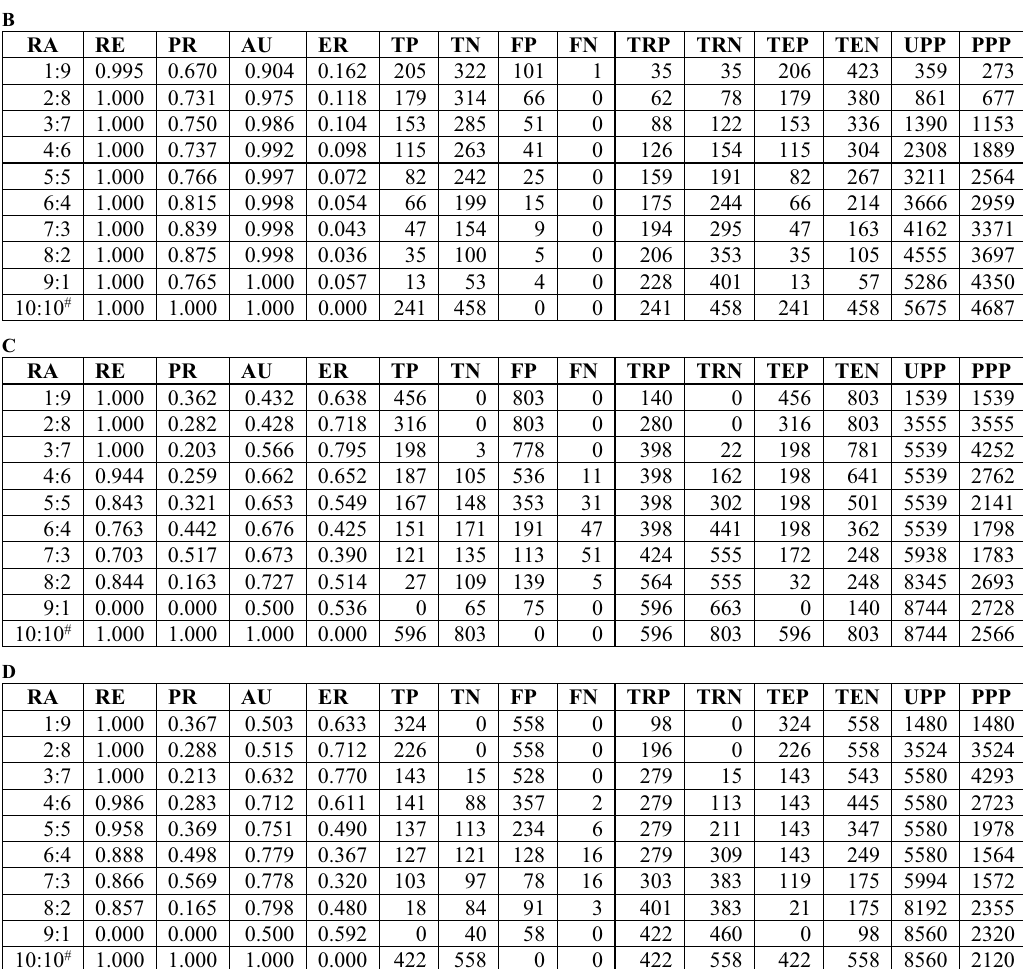
Figure 1. Performance of TC in distinguishing between observations. ( A , B ) In Breast Cancer Wisconsin (Original) data set (BCWO), we map class values “malignant” to “1” and “benign” to “0”. In case ( A ), the granularity of discretization is to the first decimal place, e.g., 1.68≈1.6, while in case ( B ) we take an integer for the granularity, e.g., 1.68≈1. ( C , D ) In Contraceptive Method Choice data set (CMC), we map class values “1 = No-use” to “1”, “2 = Long-term” to “0”, and “3 = Short-term” to “0”. For ( C ) and ( D ), we set the same granularity as that of ( A ) and ( B ), respectively. For consistency, we remove observations that have identical features but different class labels. The number of observations is thus reduced from 1473 to 1399 in ( C ) and from 1473 to 980 in ( D